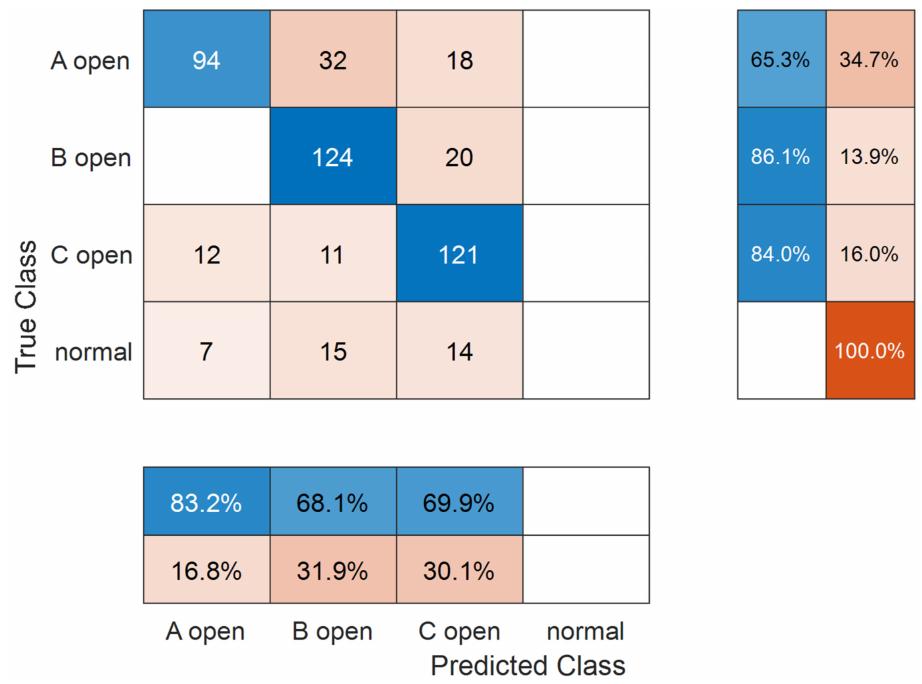
Figure 16. Confusion matrix of fault type classification model with 1/4 cycle data